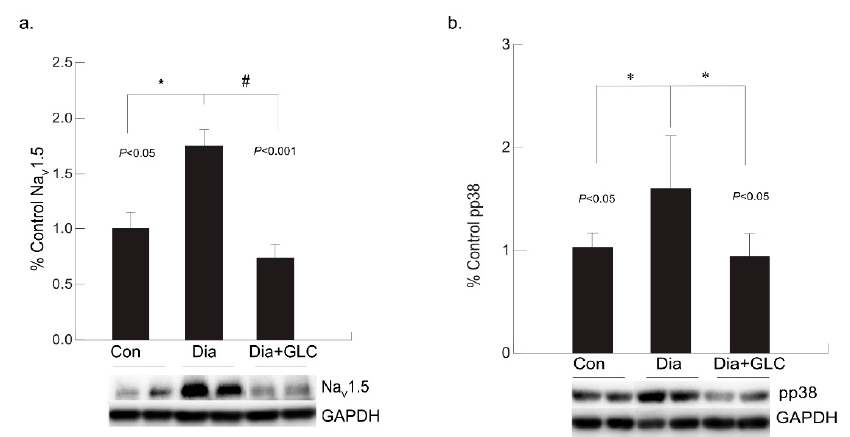
Figure 5. Anti-inflammatory effect of GLC reduced the increased voltage-gated sodium channel Na V 1.5 as well as the activation of p38 MAPK in the cardiac tissue of diabetic animals. ( a ) Increased expression of Na V 1.5 in cardiac tissue was observed in the diabetic only group of ZDF rats (* p < 0.05) whereas it was significantly ameliorated by 4 weeks of treatment with anti-inflammatory agent GLC (# p < 0.001). ( b ) p38 MAPK was greatly activated in the heart tissue under diabetic condition (* p < 0.05), whereas treatment with GLC in ZDF rats inhibited the increased phosphorylation of p38 MAPK (* p < 0.05).